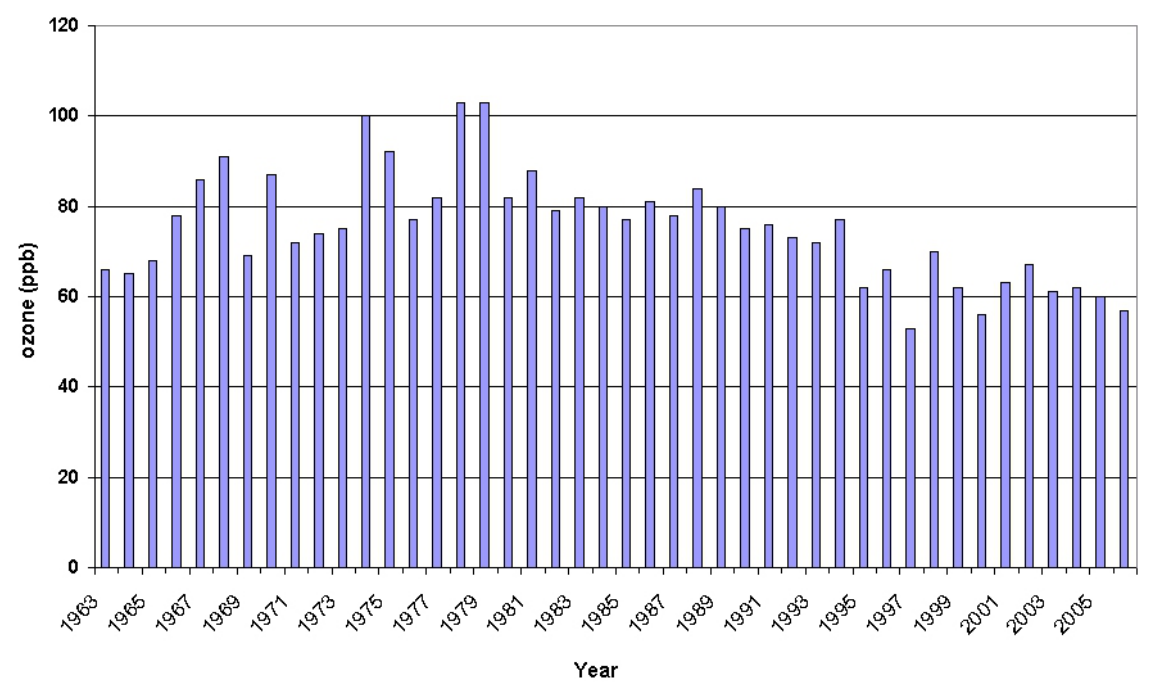
FIGURE 6. Changes in June–September mean 24-h O 3 concentrations at the Crestline/Camp site since